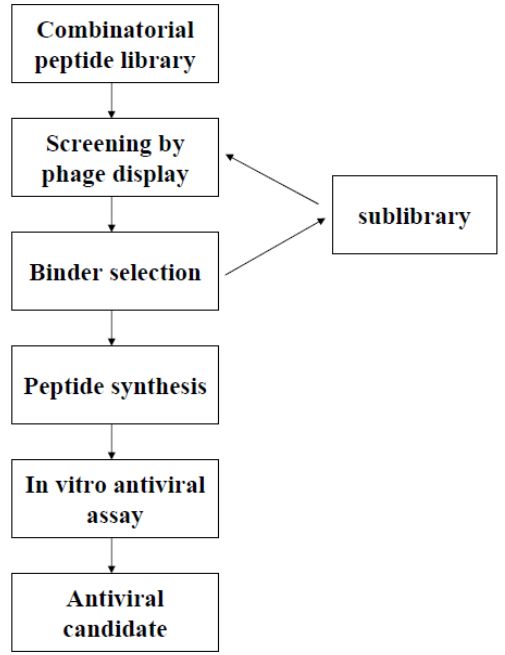
Figure 2. Process for the isolation of an antiviral peptide from combinatorial libraries by phage display